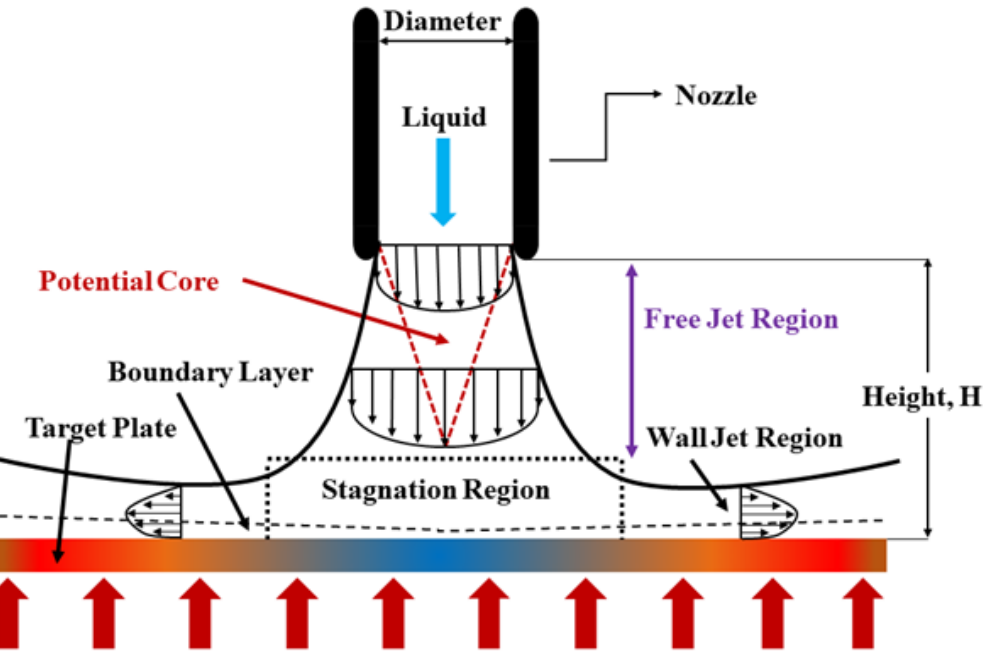
Figure 1. Flow structure of free surface jet.